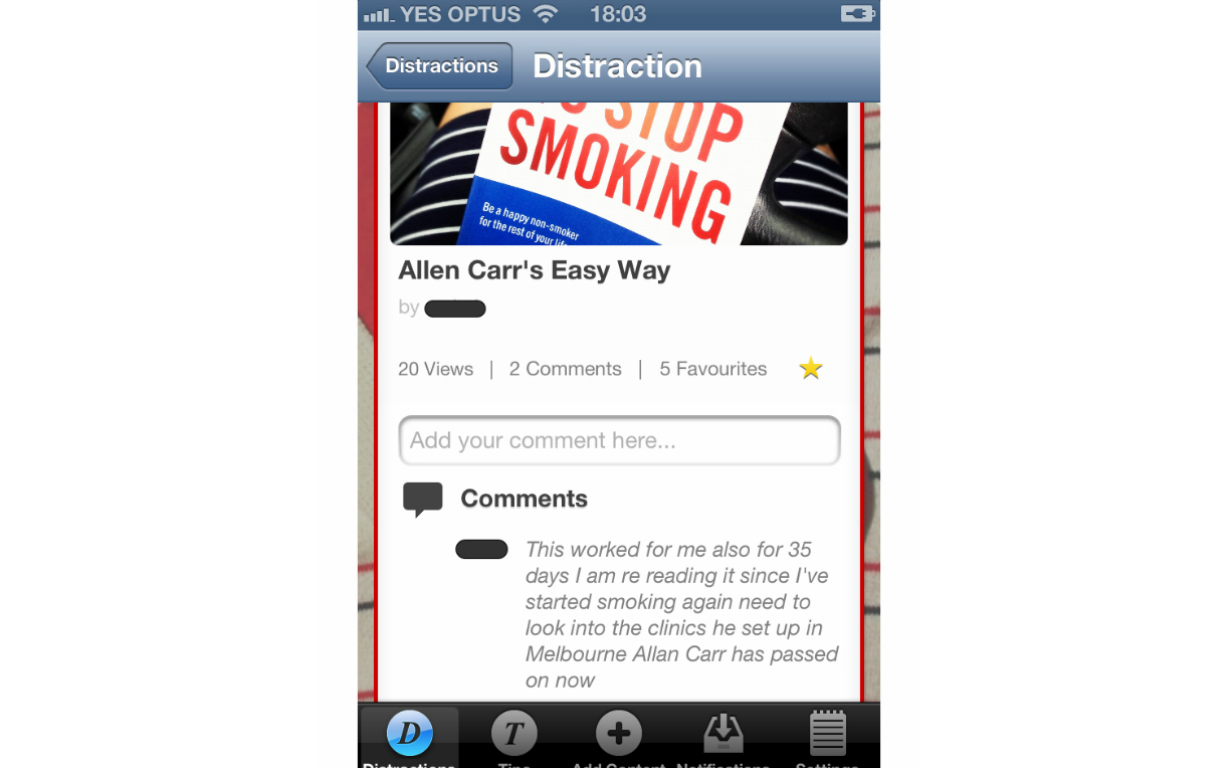
Figure 4. The participants used DistractMe to share resources to prepare for quitting.